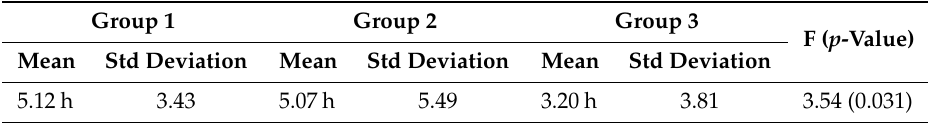
Table 7. Average daily external activity